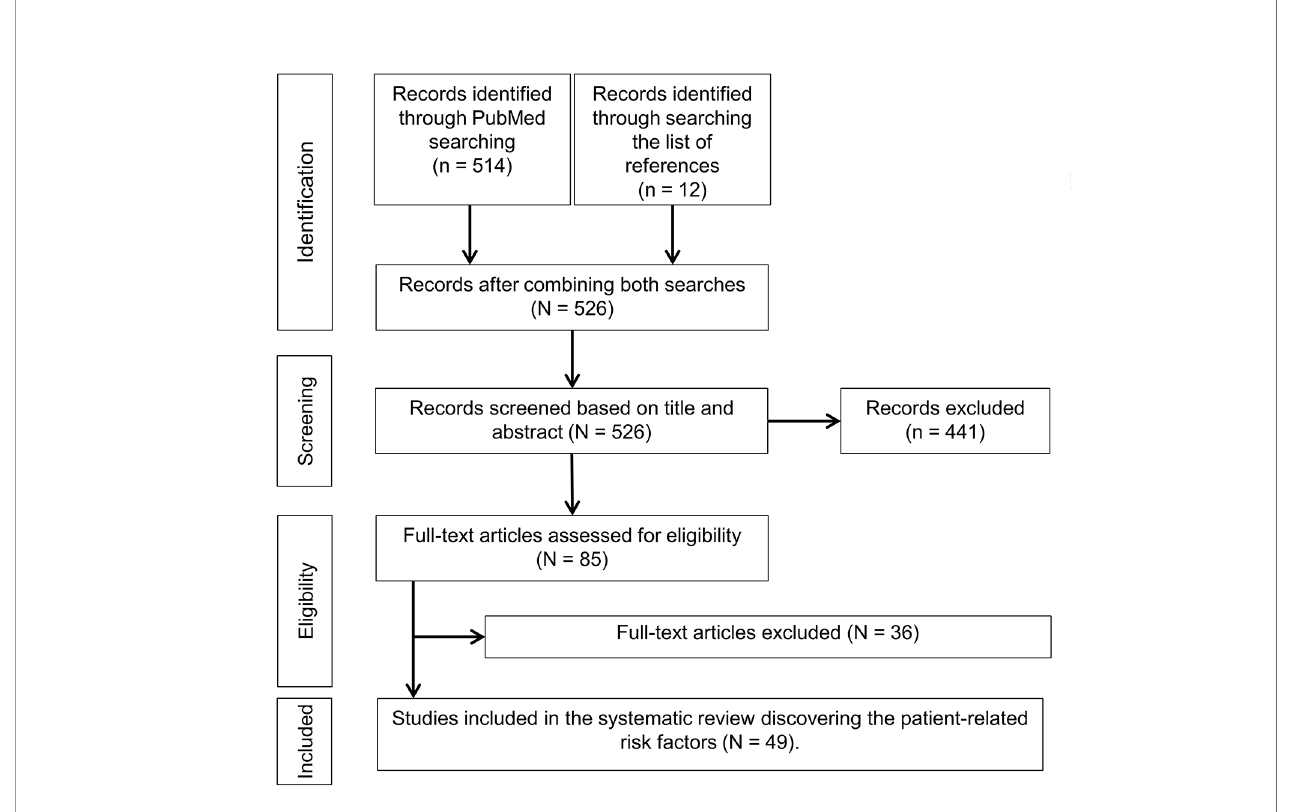
FIGURE 1 | Trial fl ow